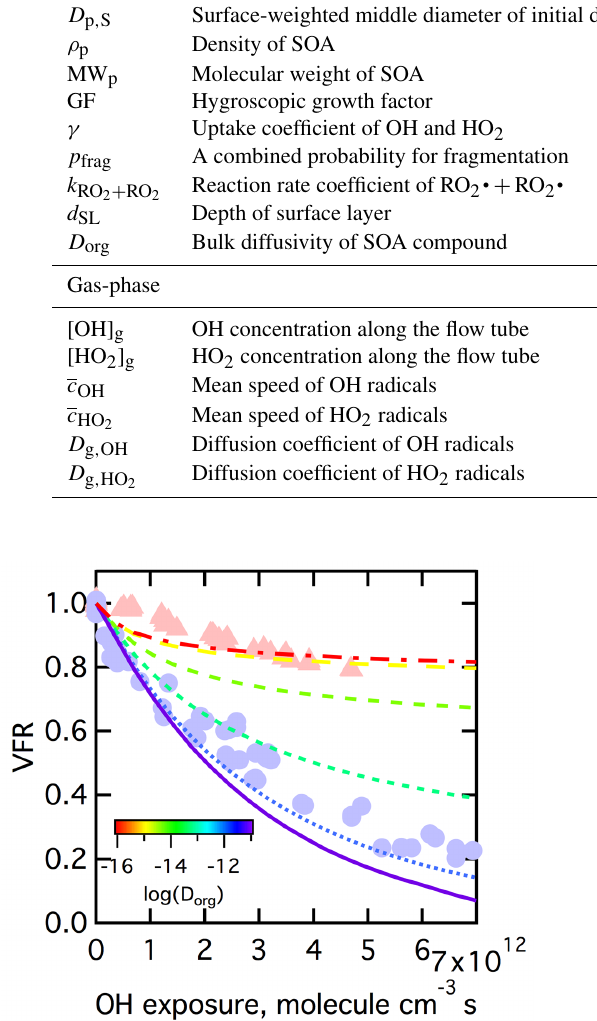
Figure 9. Comparison between observations (points) and simula- tions (lines) at varying D org values of the dependence of the volume fraction remaining (VFR) versus OH exposure for SOA for low-RH (red triangles) and high-RH (blue circles) conditions. The simu- lations assumed γ = 0 . 6, p frag = 0 . 5, GF = 1 . 0 and k RO 3 × 10 − 22 cm 3 molecule − 1 s − 1 . The D org range from 10 − 16 to 10 − 11 cm 2 s − 1 is denoted by colored